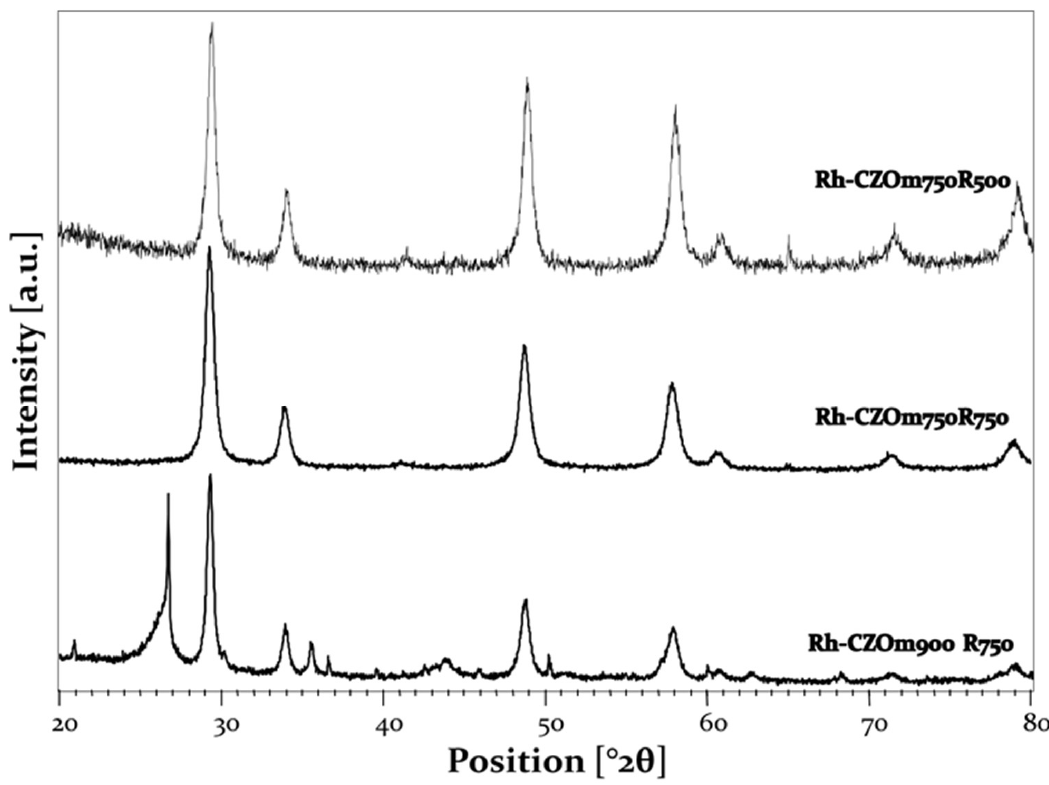
Figure 14. XRD analysis of the spent catalysts (from top to bottom) Rh-CZO-m750R500, CZO- m750R750 and Rh-CZO-m900R750.